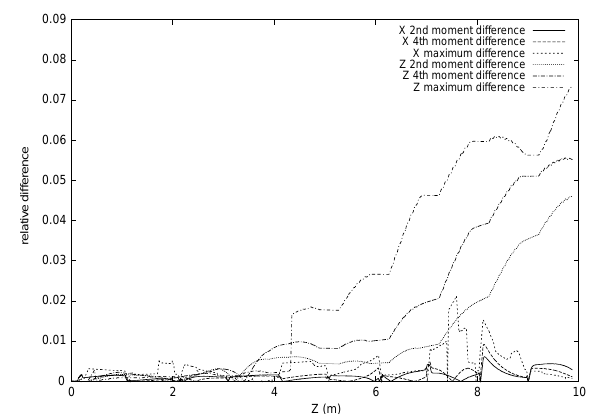
FIG. 11. The relative difference and maximum particle ampli- tude as a function of position using zeroth-order transformation with larger initial longitudinal emittance than the reference case.